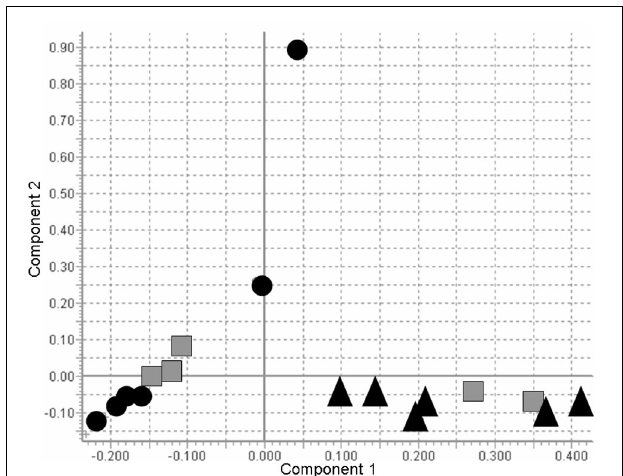
FIGURE 2 | Principal component analysis (PCA) of the GC-MS root exudate profiles collected from 2cm-subapical root zones of Lactuca